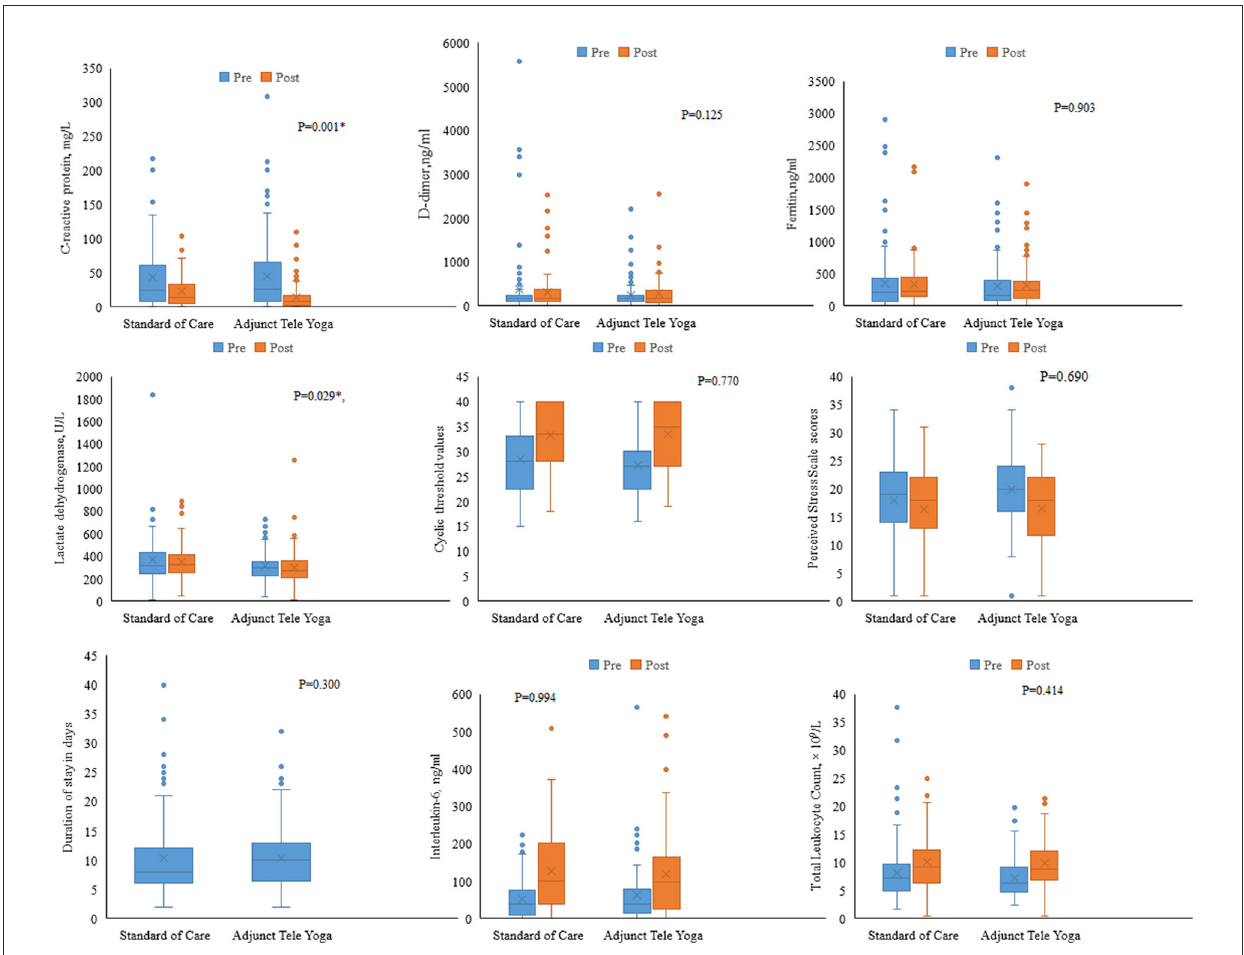
FIGURE3 Biomarker levels on day 5 post-randomization. Changes in the biomarkers on day 5 were analyzed with respect to the baseline values. Analysis of covariance was done using the rank transformation to study the influence of adjunct tele-yoga intervention on biomarker levels. *Indicates P -value <